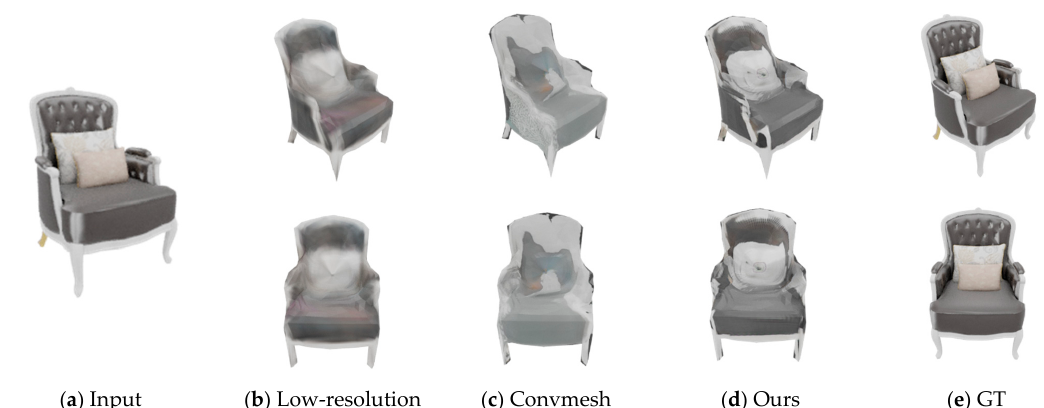
Figure 6. The texture reconstruction results. Given the input image ( a ), the reconstructed texture of mesh reconstruction ( b ), Convmesh ( c ), and our proposed texture reconstruction network ( d ) are illustrated from left to right. The rendered images with ground-truth textured meshes are presented in ( e ). Among them, image of ( e ) was rendered using low-resolution texture (128 × 128). Two views of the reconstructed results were provided for each input image.